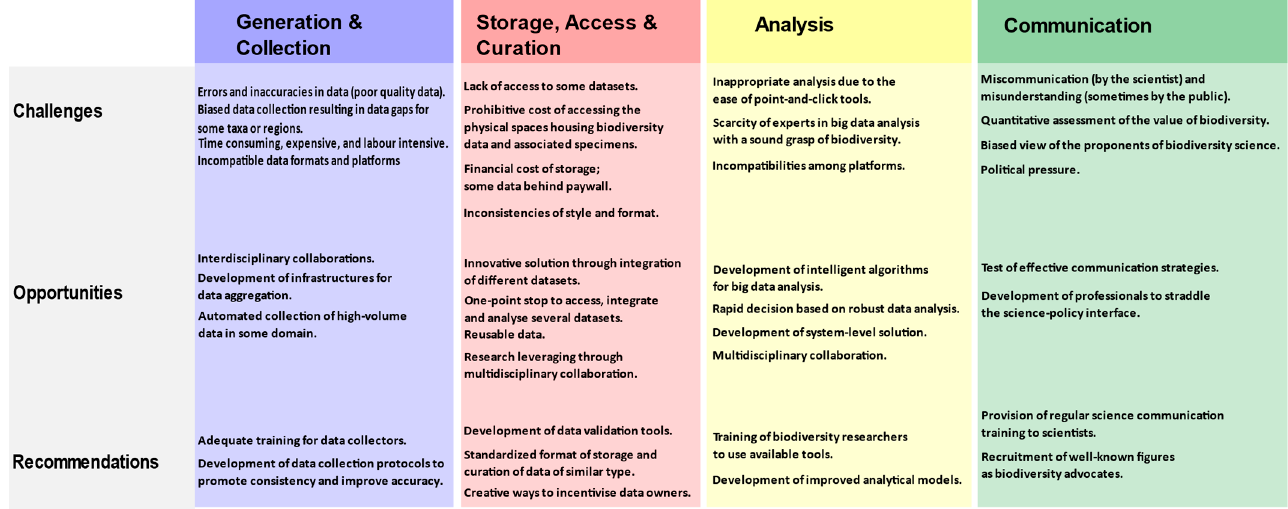
Figure 2. Summary of challenges and opportunities across BBD themes.